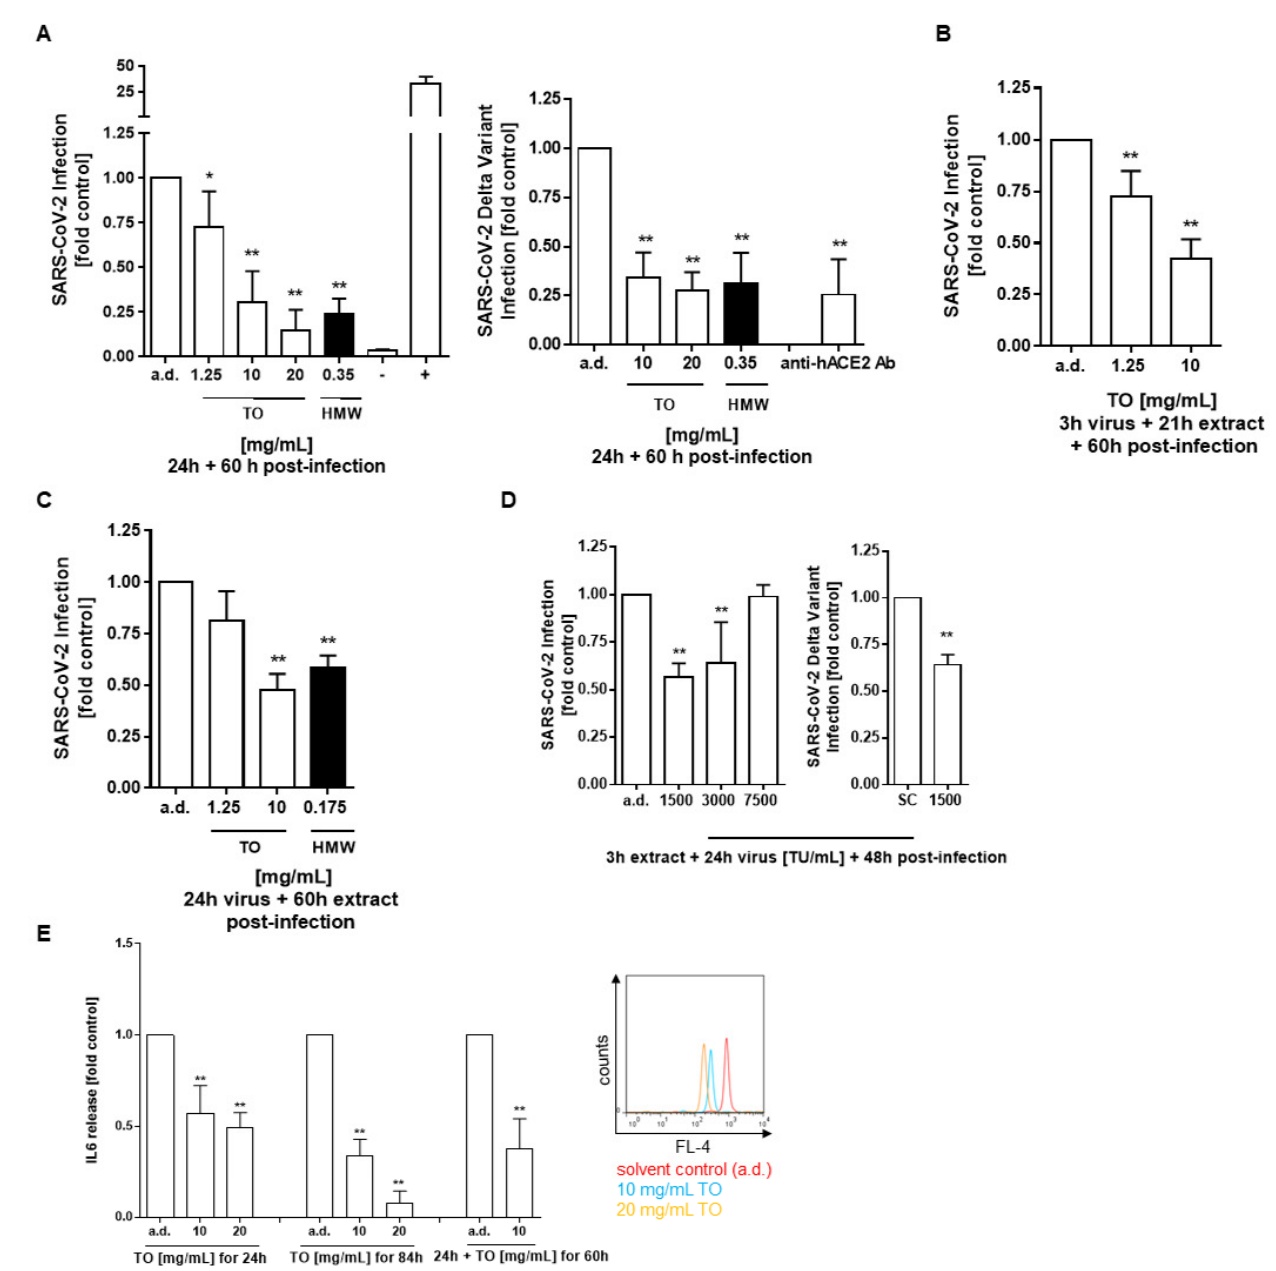
Figure 6. Viral transduction inhibition of A549-hACE2-TMPRSS2 cells by T. officinale extract. ( A ) Cells were pre-treated with T. officinale (TO) or HMW extract for 0.5 h before infection with 7500 TU/mL SARS-CoV-2 spike D614 or Delta (B.1.617.2) variant for 24 h; ( B , C ) Cells were transduced with 7500 TU/mL SARS-CoV-2 for ( B ) 3 h before addition of TO for another 21 h or ( C ) 24 h. After transduction, the medium was exchanged with fresh medium containing TO or HMW extract at the indicated concentrations and post-incubated for 60 h. ( D ) Cells were pre-treated with 40 mg/mL TO for 3 h before transduction with the indicated virus titer for 24 h. After that, the medium was exchanged with fresh medium and incubated for another 48 h. Luminescence was then detected within 1 h. 0.35 mg/mL HMW extract equals to 20 mg/mL TO extract. Transduction control: ( − ) negative control: bald lentiviral pseudovirion; (+) positive control: firefly luciferase lentivirus; inhibitor positive control: 100 µ g/mL anti-hACE2 antibody. ( E ) Pro-inflammatory IL-6 cytokine secretion analysis was done either after 24 h virus transduction together with extract (left), after 24 h + 60 h post-infection with extract (middle) or after 60 h post-infection with extract (right) using multiplexing flow cytometric analysis. Solvent control: distilled water (a.d.). N ≥ 3 independent experiments; * p < 0.05, ** p < 0.01. Significance of difference was calculated relative to the solvent control by one-way